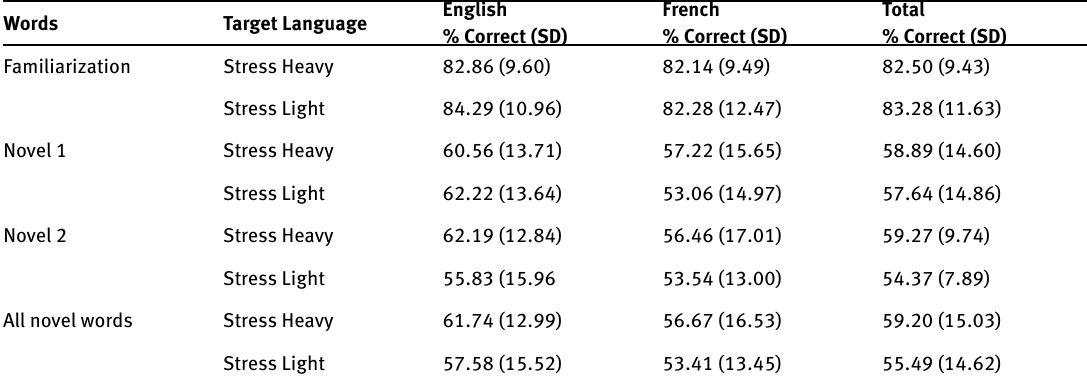
Table 5. Scores for familiarization and novel words for Stress Heavy and Stress Light